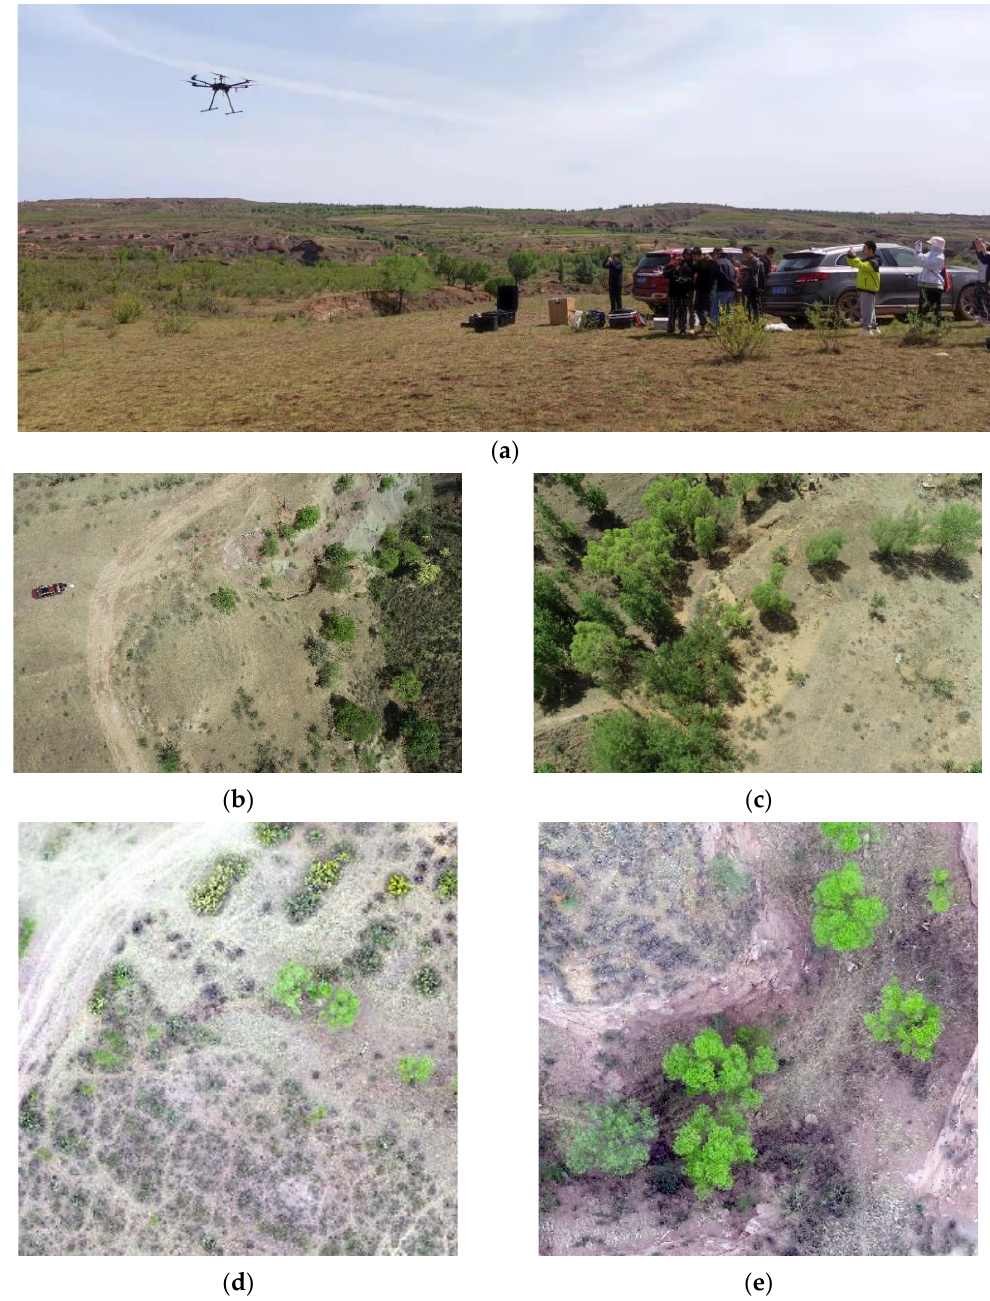
Figure 2. The field photo and the UAV images of the study area: ( a ) field photo; ( b , c ) orthophotos; ( d , e ) oblique images. ( d , e ) oblique